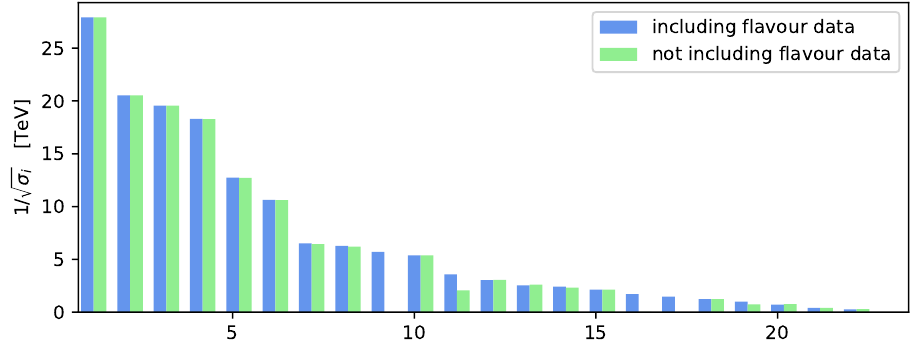
Figure 5. Comparison of the eigenvalues of the Fisher matrix assuming full U(3) 5 flavour sym- metry, for the fit including the flavour data (blue), and the fit excluding flavour data (green). We have not plotted eigenvalues for which the fit including flavour data gives 1 / setting the coefficients of all other operators to zero. 11 In orange we show fits to the full set of constraints, including flavour, while in black are the results of the fit without flavour